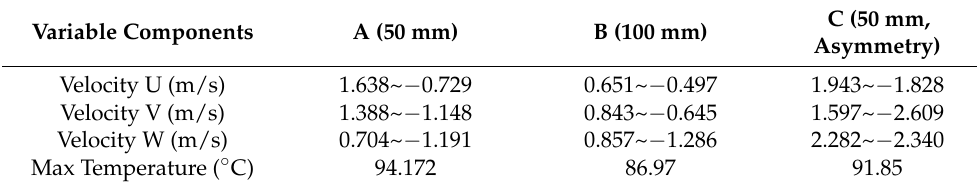
Table 5. Velocity component and temperature under each condition.